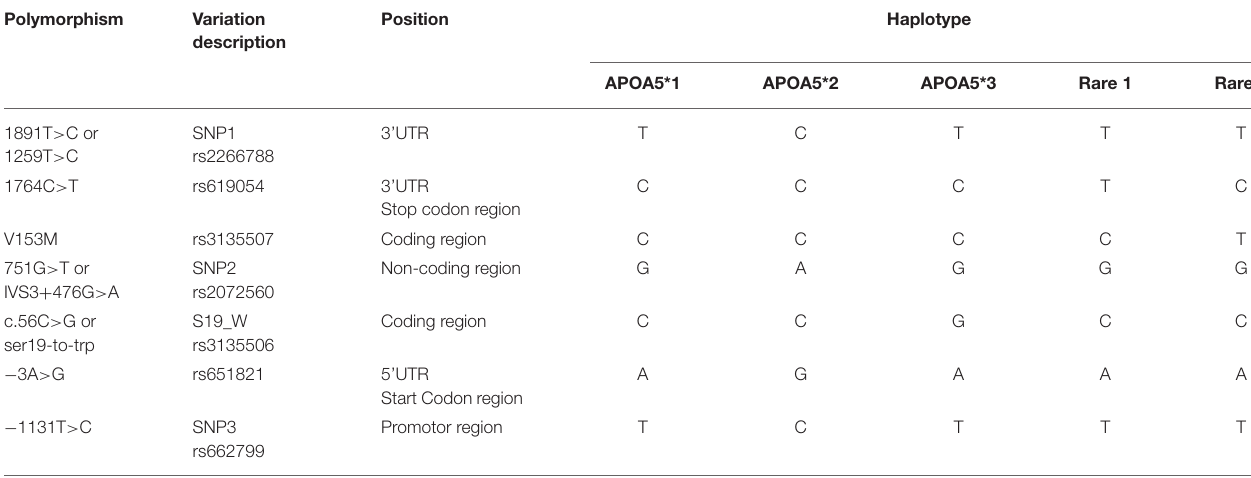
TABLE 2 | The APOA5 gene polymorphisms that contribute to the nucleotide variations in the five major haplotypes. Polymorphism